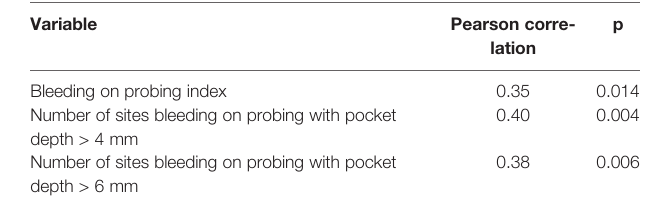
TABLE 2 | The correlations (Pearson correlation coef fi cients) between the log- transformed pleckstrin concentrations (ng/ml) and the periodontal